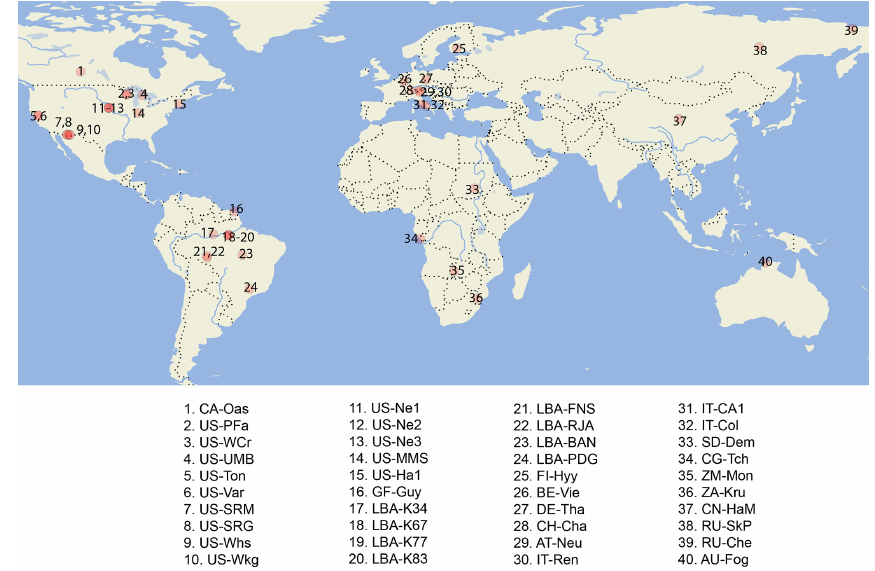
Figure 3. Location of sites used in this study. Details on site characteristics are provided in the